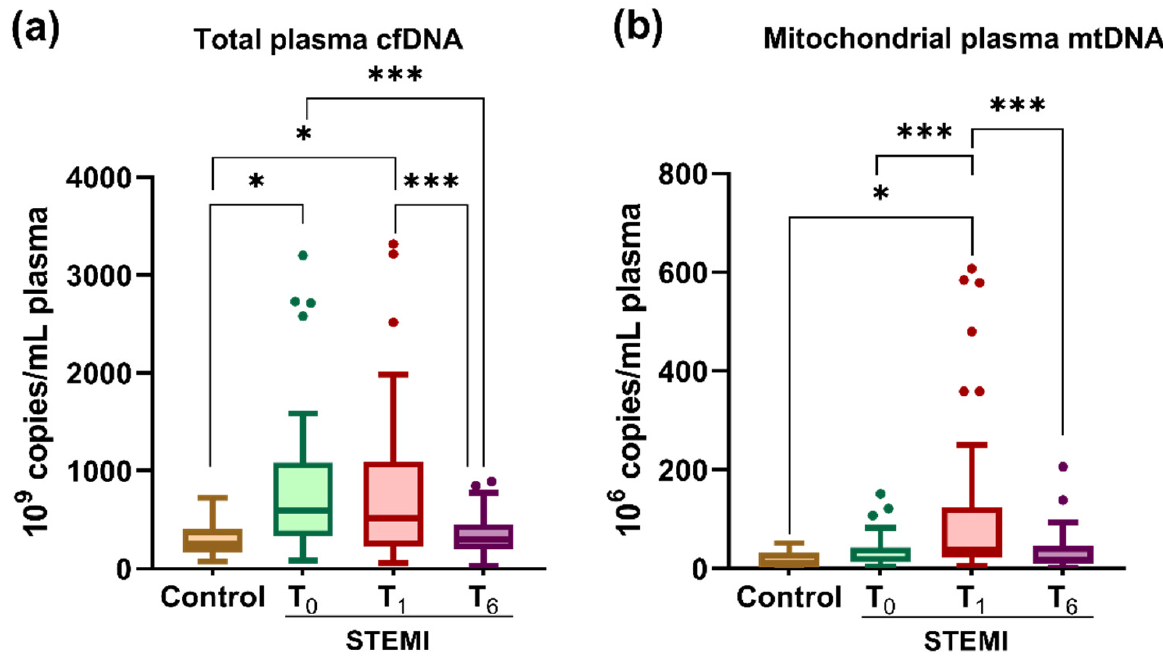
Figure 2. Levels of total cell-free (cfDNA) ( a ) and mitochondrial DNA (mtDNA) ( b ) in the plasma of ST-segment elevation myocardial infarction (STEMI) patients at T 0 , T 1 , and T 6 time points and of healthy controls. Data are illustrated as boxplots with Tukey whiskers and median line. * p < 0.05; *** p < 0.001.